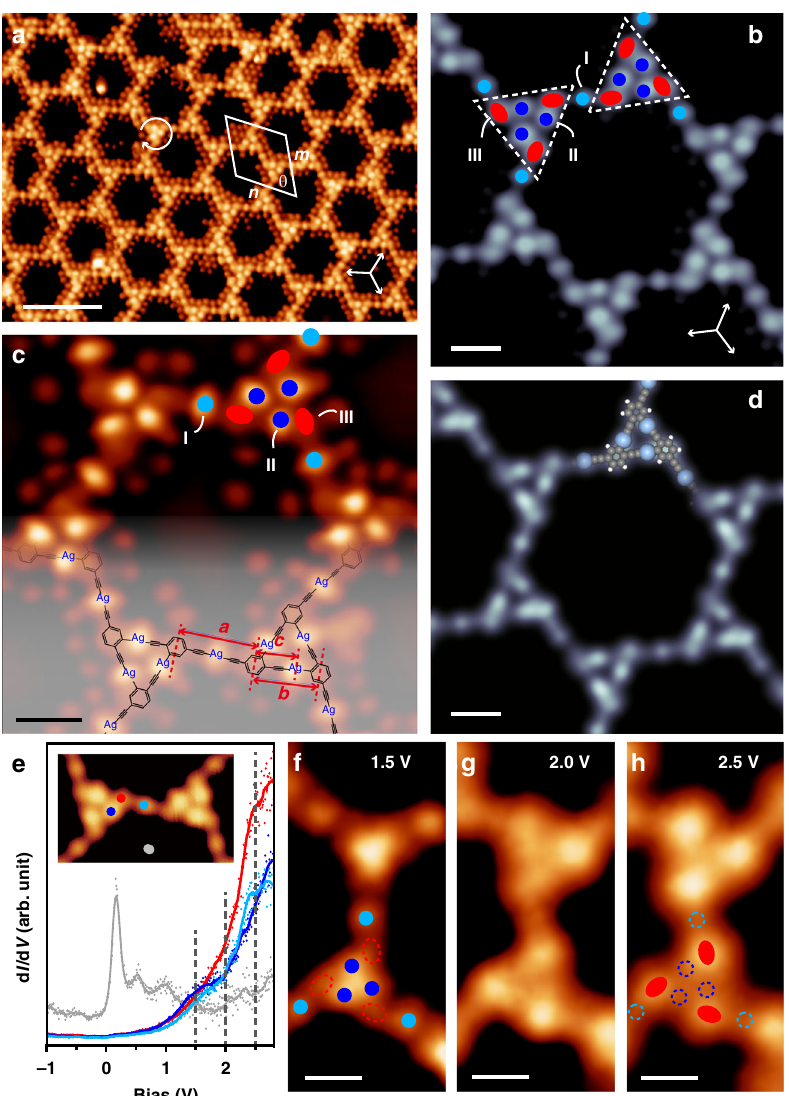
Fig. 5 2D binodal organometallic network formed at elevated temperatures. a STM image of the 2D network formed by 2Br-DEB on Ag(111) after annealing of the sample at 330 K (80 mV, 190pA, 4.2 K). The unit cell is marked by the white parallelogram. The chirality of the triangular cluster is marked by the curved arrow. b High-resolution STM image of the 2D network (640 mV, 30pA, 4.2 K). The equivalent < 1 (cid:1) 10 > directions of Ag(111) are marked by white arrows in a and b . c Constant-height STM image of the 2D network obtained by a Br-modi fi ed tip (500 mV, 100pA, 4.2 K). The molecular structure of the 2D network is superimposed. The distances between different protrusions are highlighted by the red arrows and marked with a , b and c , respectively. d Simulated STM image at 500 mV of the 2D network according to the optimized models as superimposed. e d I /d V spectra acquired on a Ag atom in an ASA node (light blue), a Ag atom in an ASP node (dark blue), a molecular moiety (red) and the substrate in a hexagonal pore (gray). Original data and smoothed results are presented by the dots and the lines, respectively. Constant-height d I /d V mappings acquired at biases of f 1.5 V, g 2.0 V and h 2.5 V. Scale bars: a 5 nm, b – d , f – h 1 network, spacings between the molecular moieties in the network The resulted STM image displayed in Fig. 5c shows that the (red arrows a and b in Fig. 5c) were measured to be a = 1.23 protrusions of types I and II (light and dark blue dots) appear in ±0.04 nm and b = 0.98±0.05 nm. These values are in good similar brightness and are much brighter than the ones of type III (red dots), indicative of their different chemical nature. The dramatic difference in contrast of the three types of protrusions suggests that the 2D network be a bi-component structure. Given that the on-surface reaction solely involves the molecules and the silver substrate, one can conclude that the bi-component network of the Ag atoms in between the molecules: The Ag atom between is a metal-organic hybrid structure consisting of the molecular the molecules separated by a spacing of a sits in the right middle moieties and Ag adatoms. The protrusions of types I and II are of two neighboring molecules, which agrees with the situation in identi fi ed as the Ag atoms due to their smaller size and higher an ASA node. The Ag atom between the molecules at a spacing of brightness 31 and the type III protrusions, the molecular moieties. To fi gure out how the molecules and Ag atoms are bonded in the b locates far from one of the molecules at a distance of c = 0.61